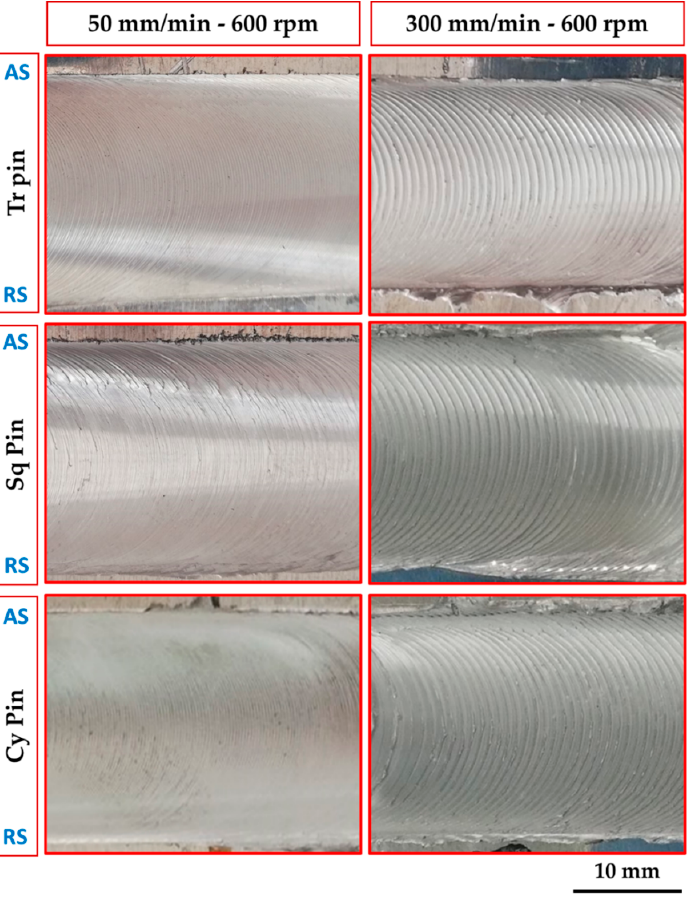
Figure 12. Photo images showing the macro-morphology of the BT-FSPed AA1050 at 50 and 300 travel speeds and a constant rotation speed of 600 rpm using different pin geometries.